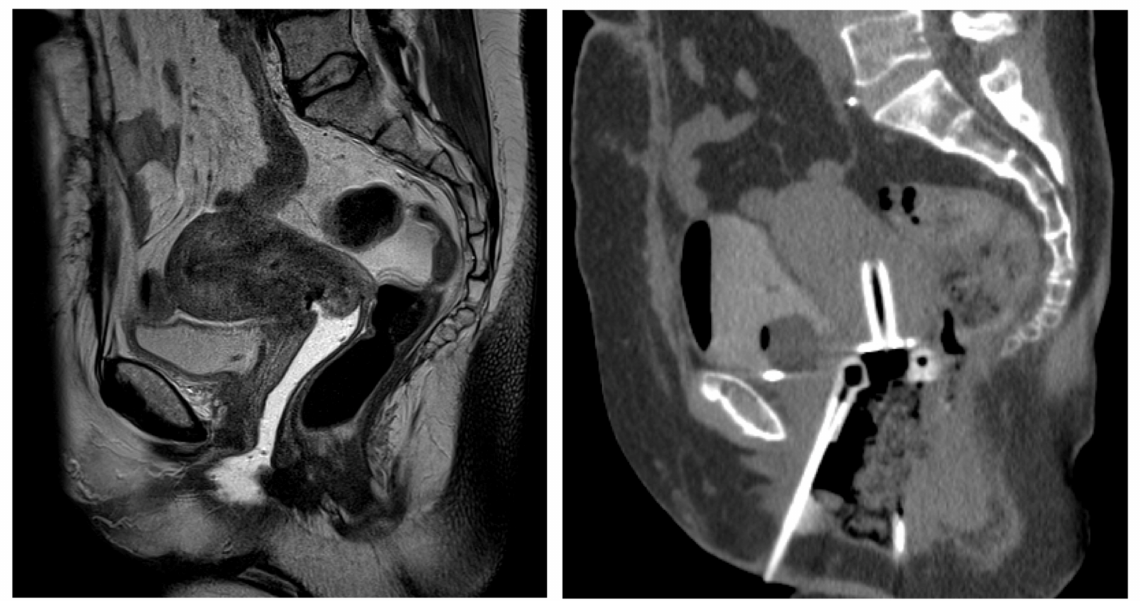
Figure 2. A uterus erected by the insertion of the vaginal applicator.